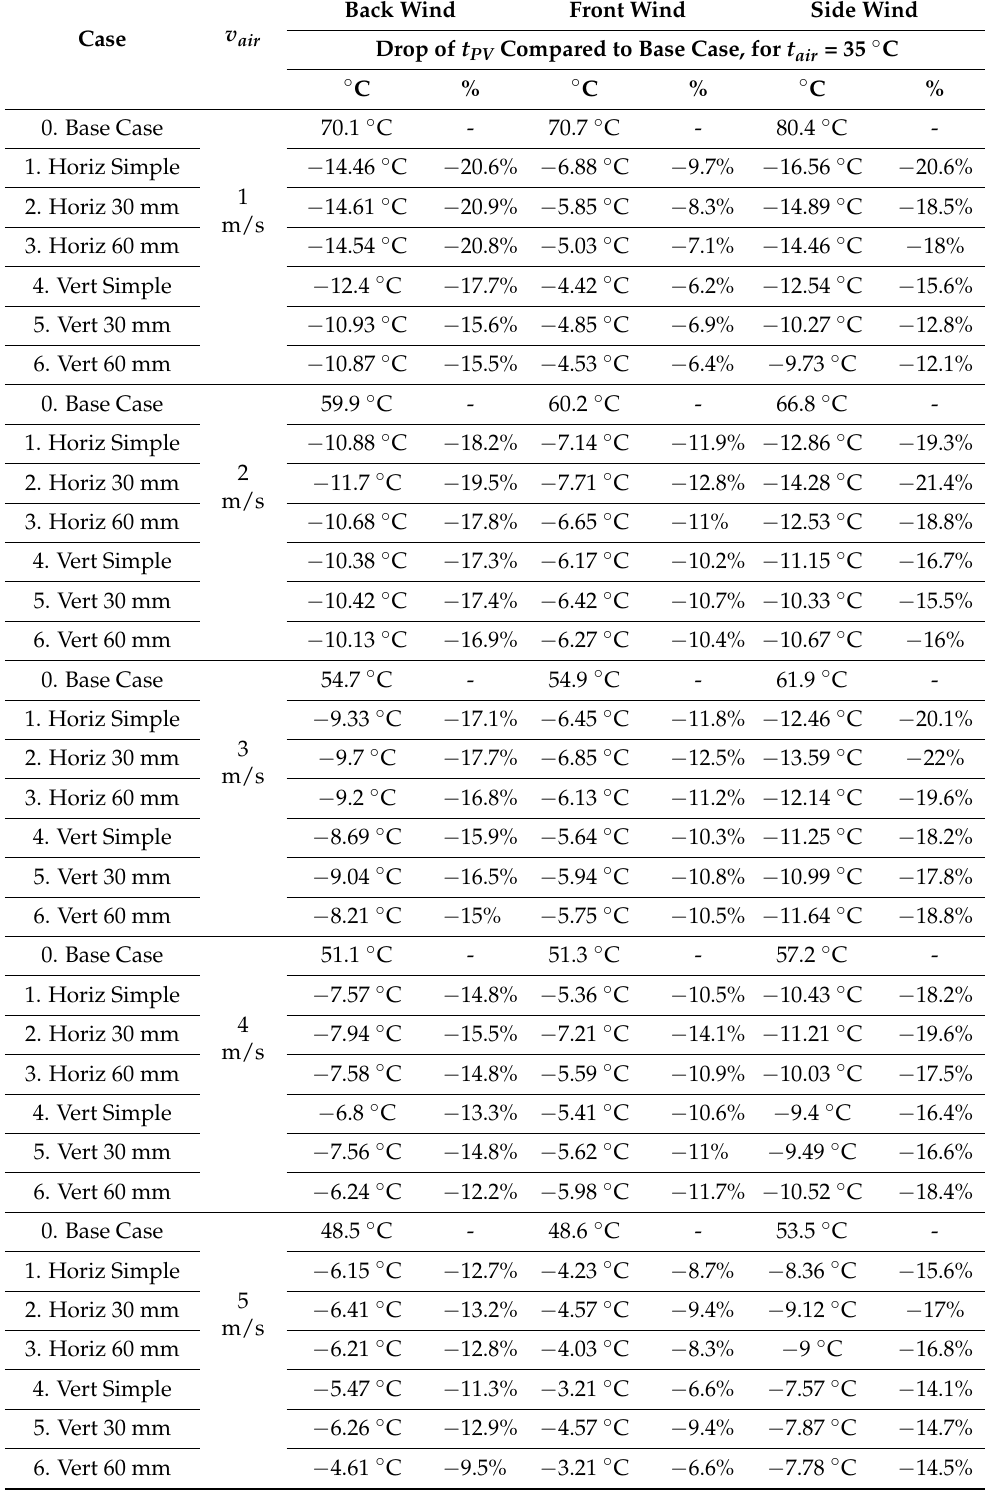
Table 5. Operating temperature of PV panel for studied